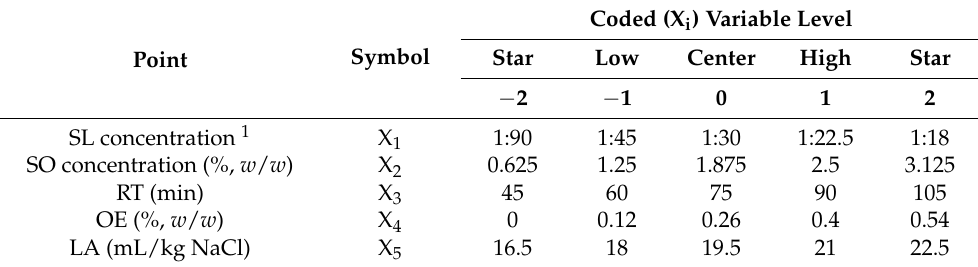
Table 1. Coded and uncoded physical values of operational parameters used in the CCD.